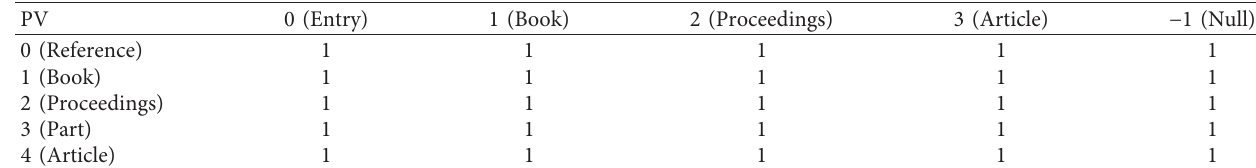
Table 1: An example of initialized PV.